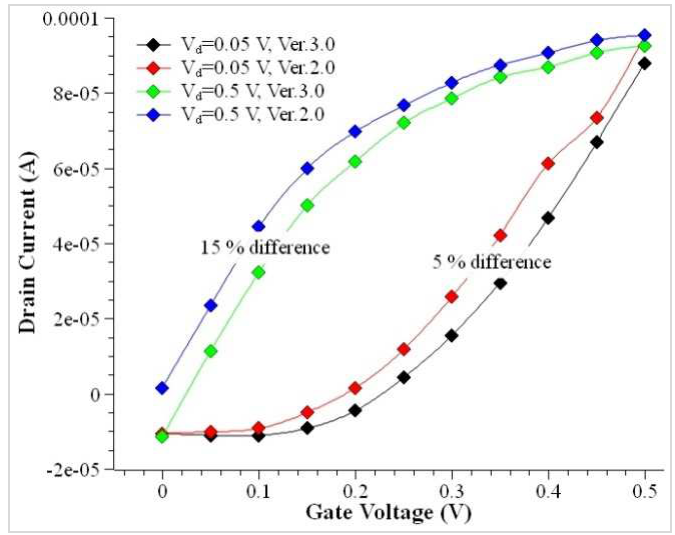
Figure 2. Comparison of the current environment with the conventional tool.